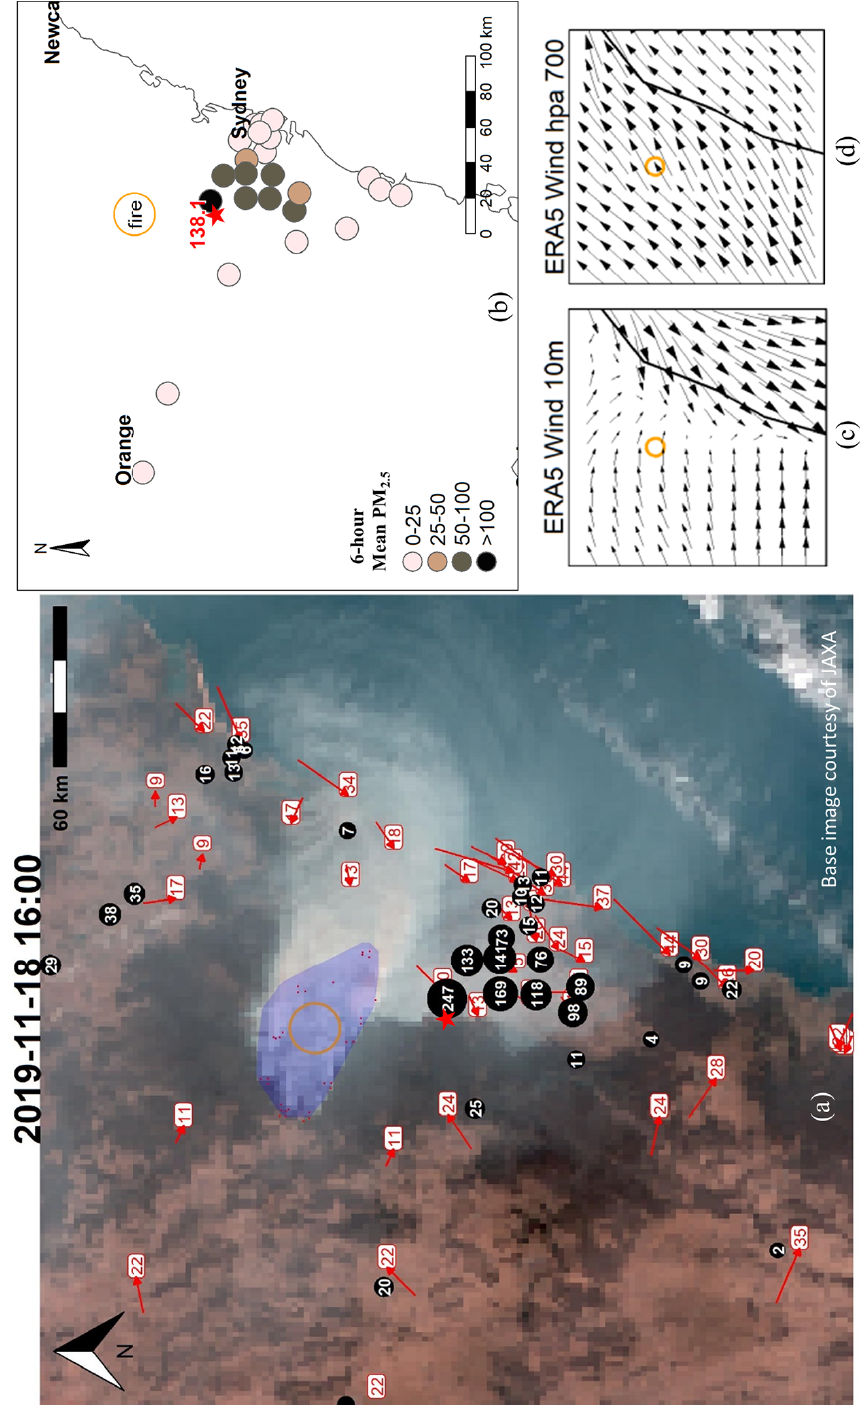
Figure A2. Wildfire afternoon 2. The second highest mean afternoon WF PM 2 . 5 was 138.1µgm − 3 at Richmond AQS (red star), which was the closest to the fire at ∼ 50km. This was also the Gospers Mountain fire. Six other AQSs in the Sydney basin had mean PM 2 . 5 > 50 (b) . The smoke flow appears multidirectional (a) : to the south with surface winds (c) and to the east with upper-level winds (d) . The southerly flow appears to be due to the meeting of surface westerly winds and a NE sea breeze (c) . The smoke flowing to the east appears to be above the surface and above the sea breeze as the AQS directly to the east of the fire was under the plume but only recording PM 2 . 5 of 7µgm − 3 (a) . The preceding morning had northerly winds blowing smoke directly into Sydney, with several AQSs recording hourly values in the hundreds, so lingering smoke was likely a contributor. This fire burnt through the following night, but PM 2 . 5 levels dropped substantially across Sydney (all < 25µgm − 3 ) until 02:00AEST, when PM 2 . 5 increased again (Fig.